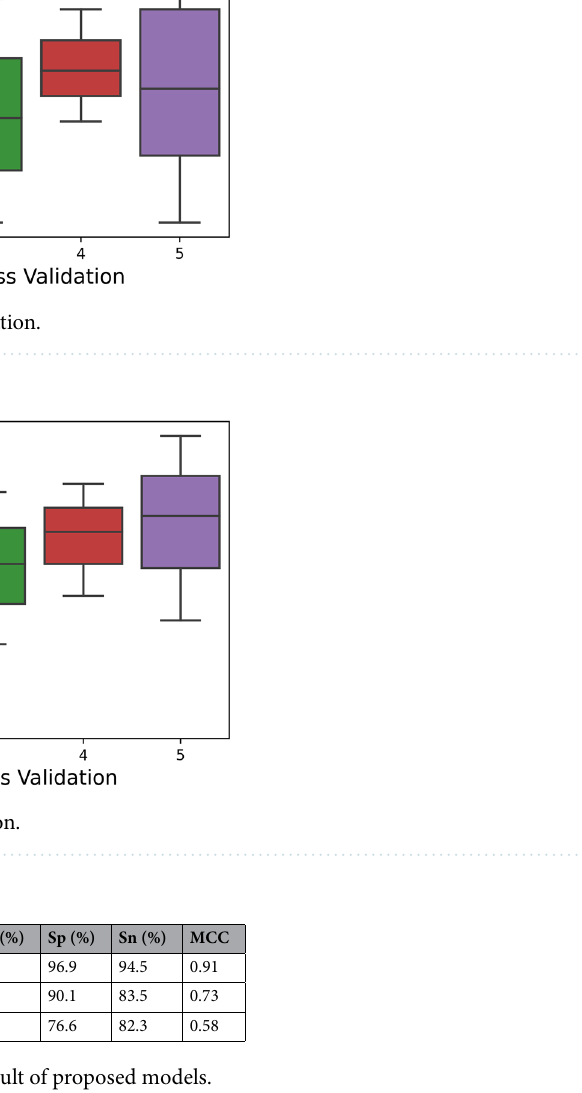
Table 6. Tenfold cross-validation result of proposed